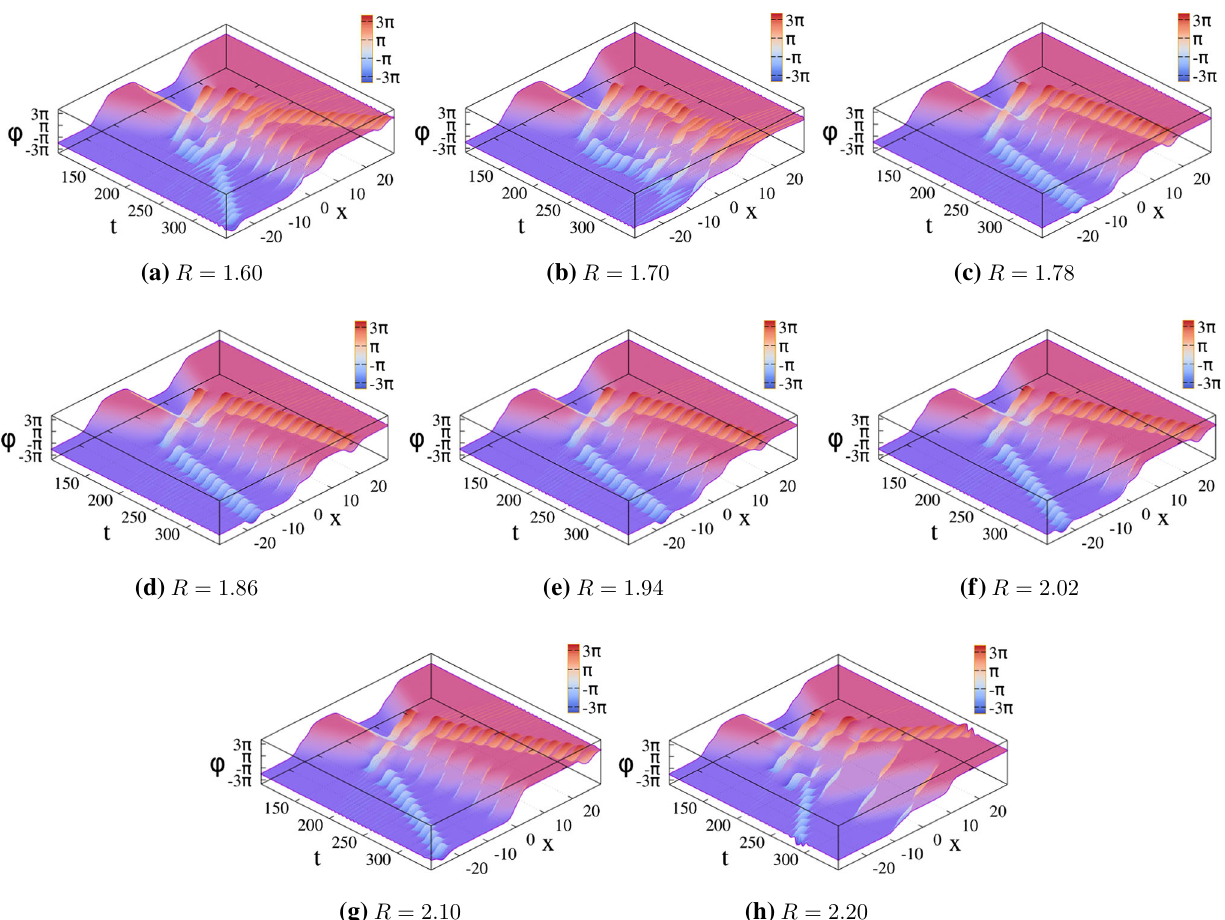
Fig. 11 Space-time picture of collisions of three kinks for some R ’s from the range 1 . 6 ≤ R ≤ 2 . 2